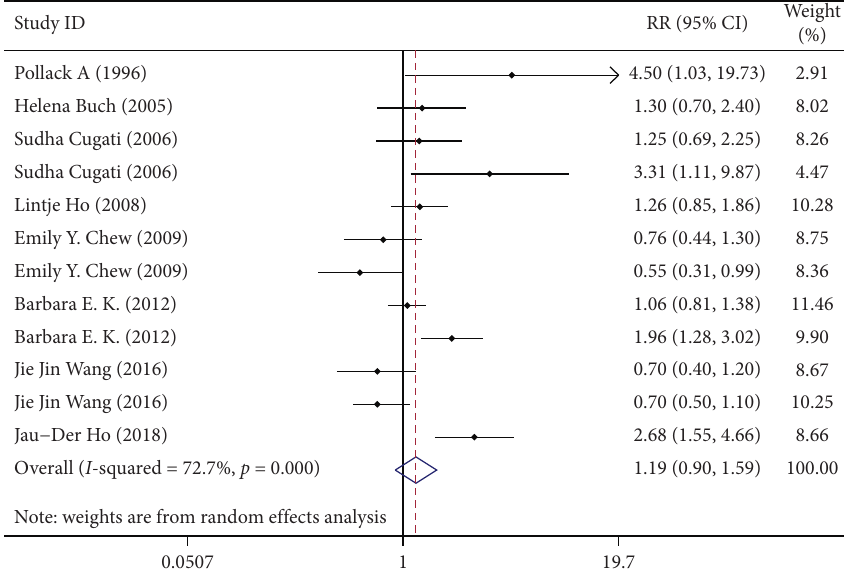
Figure 4: The RR for cataract surgery and AMD in the random effects